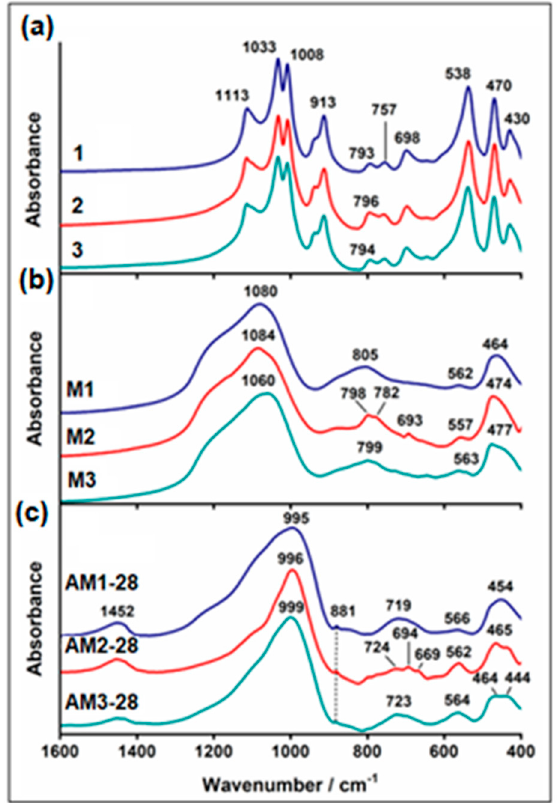
Figure 4. MIR spectra of: ( a ) kaolins, ( b ) metakaolins, and ( c ) alkali-activated metakaolins for 28 days. The high intensity of the kaolinite bands, overlapping the bands of the minerals’ admixture, hinders the identification of the impurities in the kaolins. The only exception is kaolin 2, where an increase in intensity and a slight shift of the Si–O band to higher wavenumbers (796 cm − 1 ) compared to kaolins 1 and 2 reflects a higher content of quartz in this sample. For quartz, a doublet near 800 and 780 cm − 1 is diagnostic